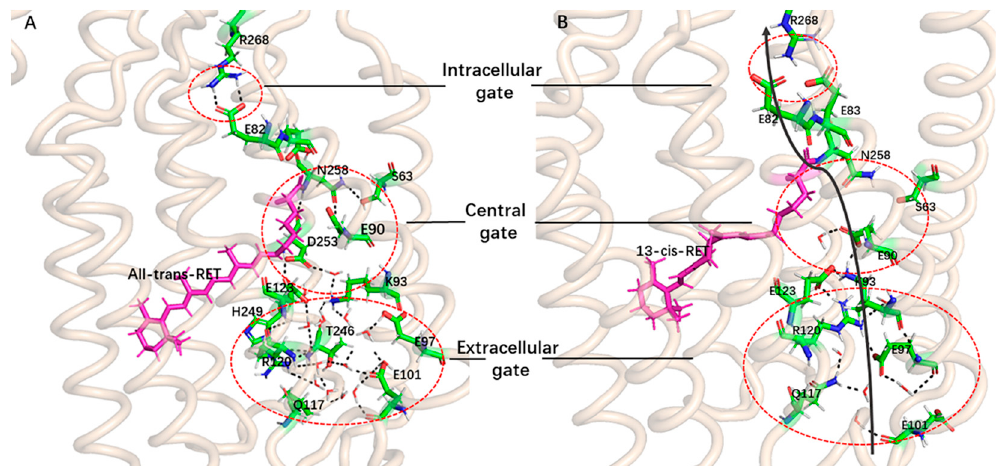
Figure 5. Structure comparison of ChR2-trans and ChR2-cis. ( A ) Structure of ChR2-trans in equilibrium trajectory. ( B ) The first cluster representative structure of ChR2-cis. In the figure, the black solid arrow represents the potential ion channel, the red dotted circle highlights the ICG, CG and the ECG in the pores of the protein channel. The hydrogen bonding between key residues is indicated by a black dotted line.